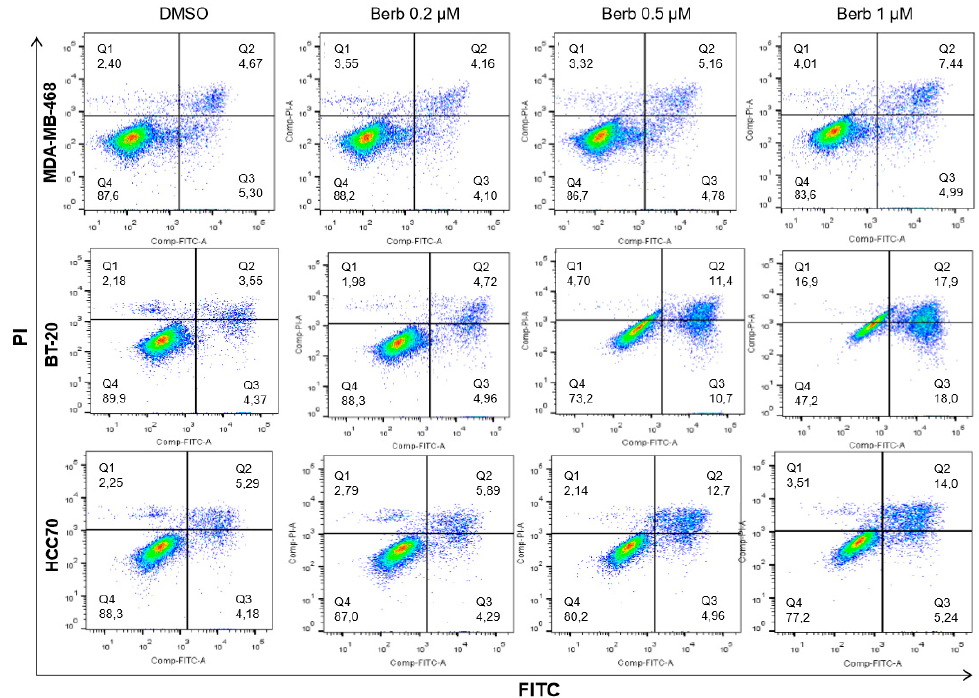
Figure 6. Annexin-V FITC and PI staining on TNBC cell lines: MDA-MB-468, BT-20 and HCC70 following the treatment with berberine (µM) 0.2, 0.5 and 1, at 144h. Q1: PI+/FITC-; Q2: PI+/FITC+; Q3: PI-/FITC+;Q4: PI-/FITC-. Berb—Berberine.